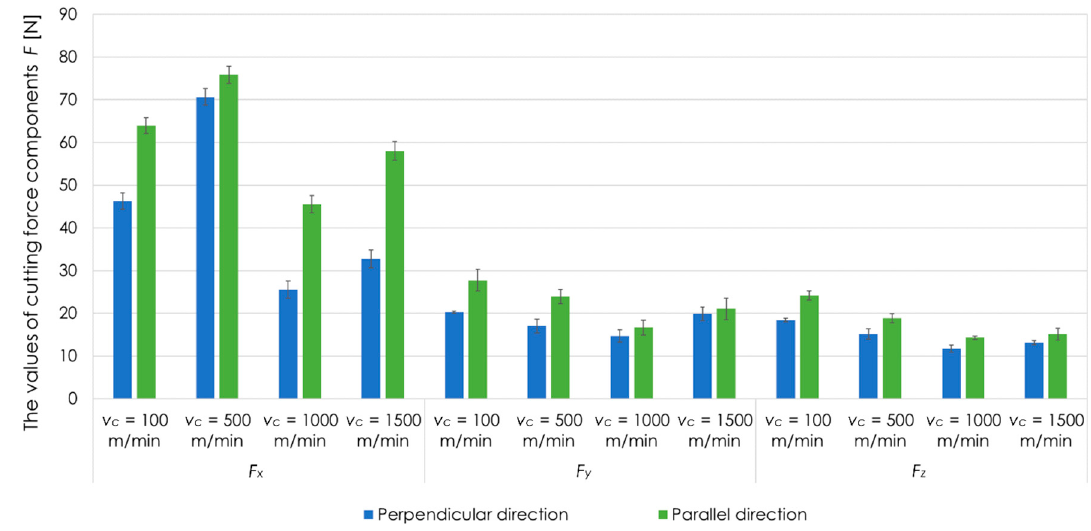
Figure 5. Cutting force components F x , F y , F z , for EN AW-2017A T451 aluminium alloy, tested cutting speeds v c , perpendicular and parallel milling direction in relation to the rolling direction, a p = 0.4 mm.